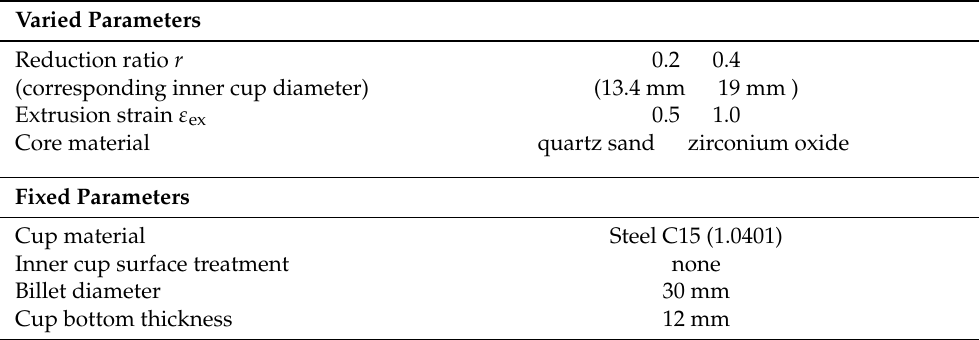
Table 2. Investigated parameters in cold forging with granular media acting as lost